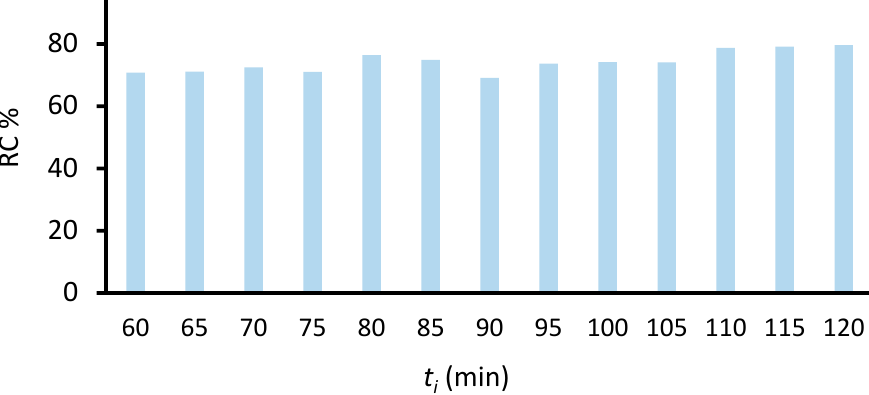
Figure 4. Relative reduction of water absorption by capillarity ( RC %), calculated using Equation (2), vs. treatment time ( t i ) for which the uncoated and coated marble samples had been in contact with liquid water.